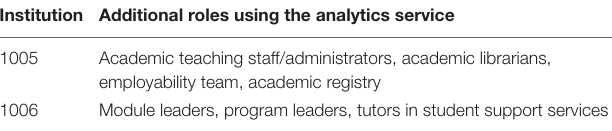
TABLE 5 | Q9: What other roles make use of the